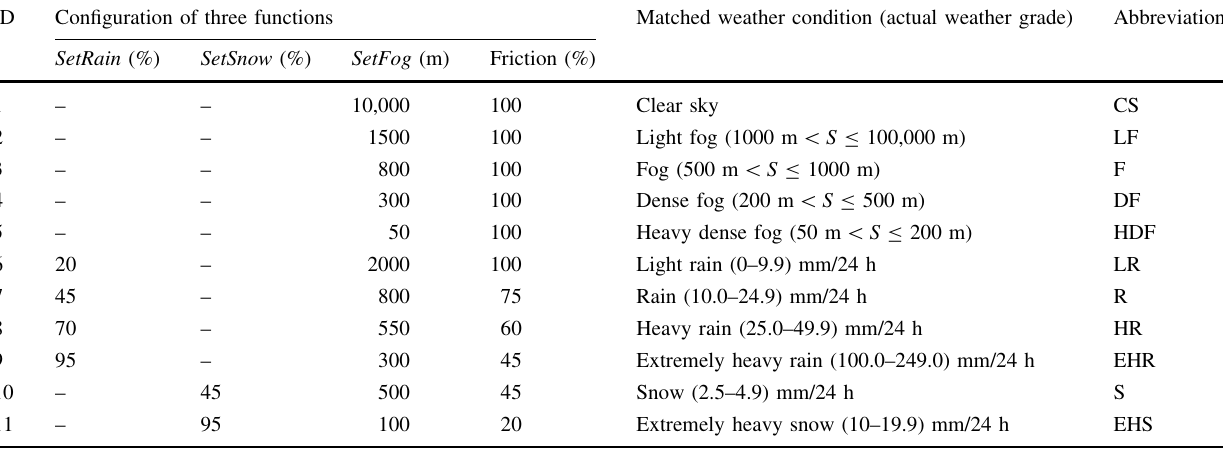
Table 1 Configurations of the 11 weather